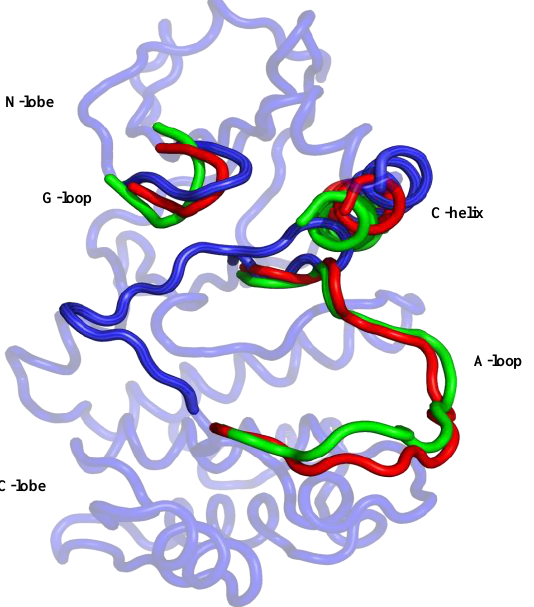
Figure 2. Graphical representation of the main differences between the two active/open states (phosphorylated/unphosphorylated) and the inactive/closed state of the Aurora-A protein. The closed conformation is represented in blue (PDB 4J8M) and the protein regions of the open forms in the phosphorylated and unphosphorylated states are colored in the green (PDB 1OL7) and red (PDB 1MQ4), respectively.